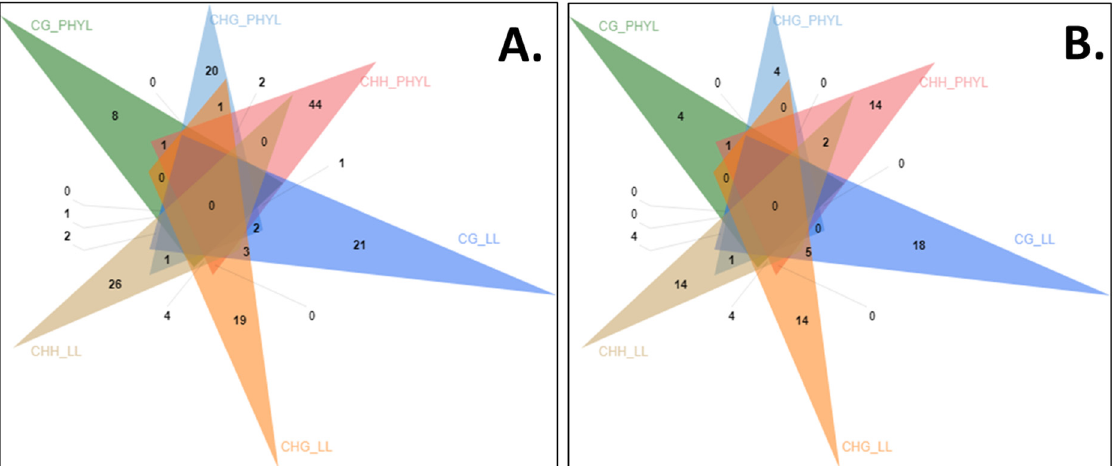
Figure 8. Venn diagram representing hypomethylated ( A ) and hypermethylated genes ( B ) in CG, CHG and CHH contexts. PHYL-phyllody affected sesame, LL-little leaf affected